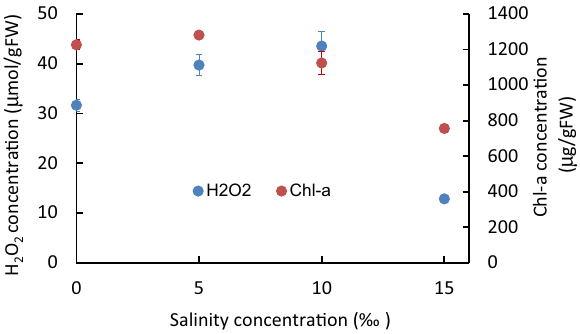
Figure 4. The variation of H 2 O 2 and Chl- a concentrations after 7 days’ exposure to the different salinity concentrations. Vertical bars indicate the standard